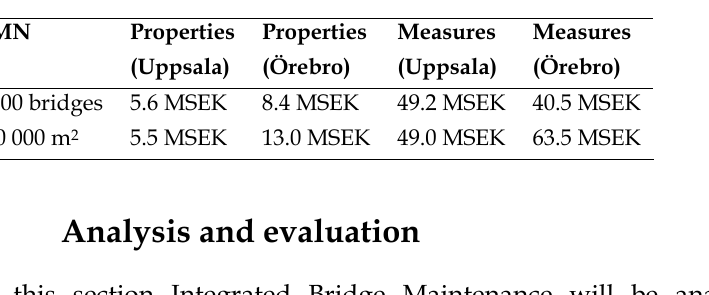
Table 9. Estimates for VMN’s whole bridge stock based on SRA-P’s winning tender bids in the Uppsala and Örebro